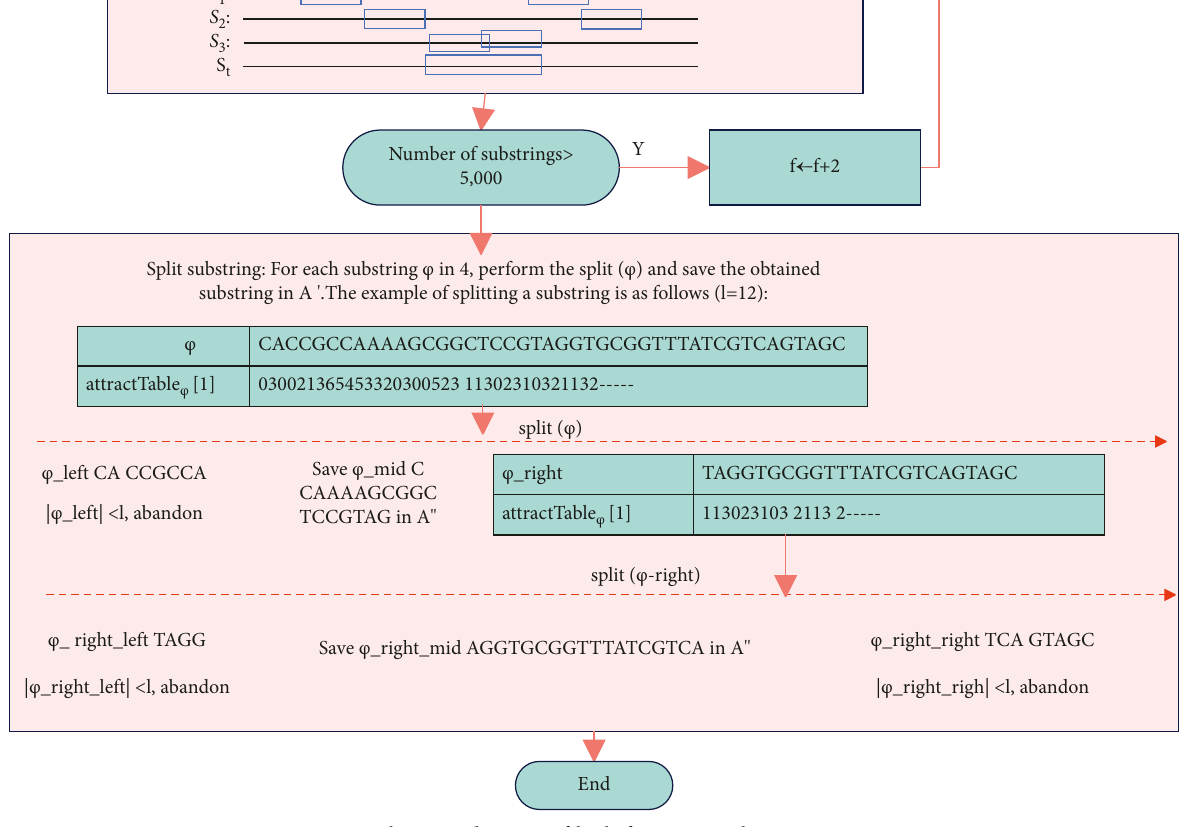
Figure 2: Schematic diagram of high-frequency substring